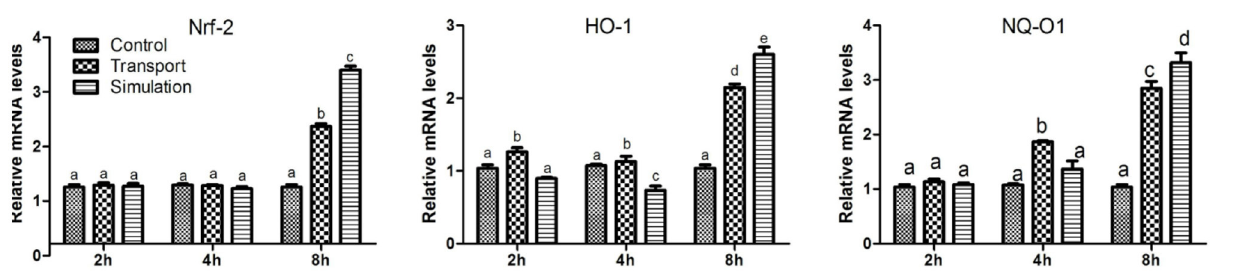
FIGURE 5 | Effect of transport stress on Nrf2/HO-1/NQO1 signaling pathway in heart tissue of newborn chicks (the expression of Nrf2/HO-1/NQO1 mRNA). Data are presented as the mean ± SD. Compared with the control: Row (Column) with different small letter superscripts indicates a significant difference ( p < 0.05); Row (Column) with different small letter superscripts indicates no significant difference ( p > 0.05). Control, the control groups; Transport, the transport groups; Simulation, the simulation transport